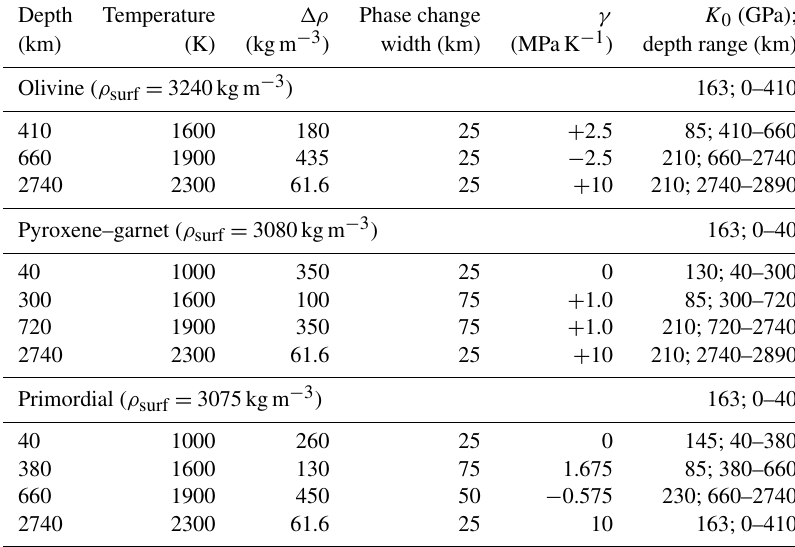
Table 2. Parameters for the phase transitions for the olivine, pyroxene–garnet, and primordial systems. The primordial system is parameter- ized to fit the density profile of a mechanical mixture of 40% basalt and 60% harzburgite from Xu et al. (2008) in the upper mantle (see Supplement S1.2). These parameters include the depth and temperature at which the phase transition occurs, the density jump across the phase transition ( (cid:49)ρ pc ), and the Clapeyron slope ( γ ). The olivine and pyroxene–garnet system parameters are similar to previous studies (e.g., Tackley et al., 2013). Finally, the reference bulk modulus for each individual layer of a system is shown as K 0 , which is increased to 230GPa for primordial material in the lower mantle, as discussed in Supplement S1.2.